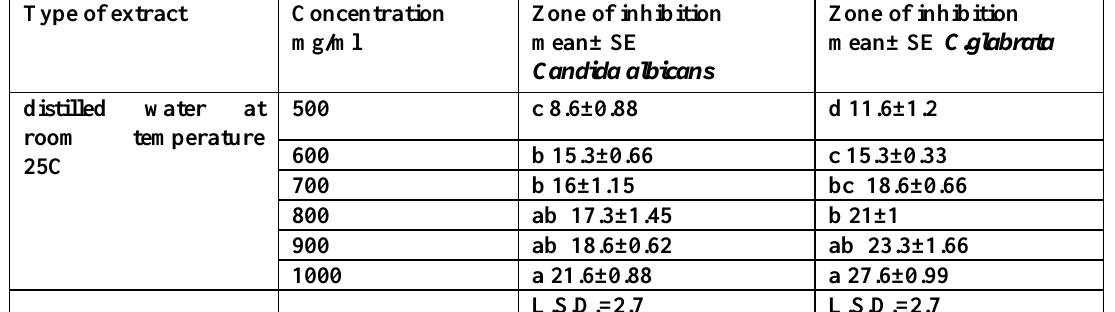
Table 4: The effects of Aqueous (distilled water at room temperature 25C) of Quercus infectoria on Candida albicans and C.glabrata in